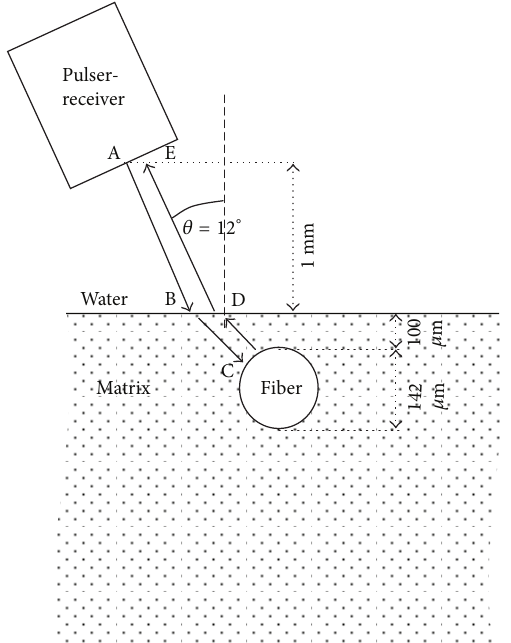
Figure 2: Geometry of the simulated test including wave directions.